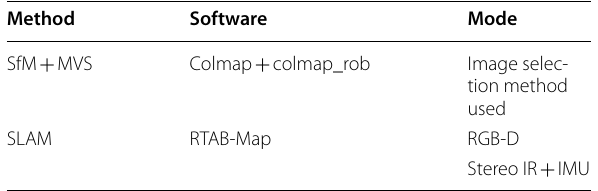
Table 9 Average illumination measured by 18 points along the boundary walls in each illumination condition variation Illumination condition